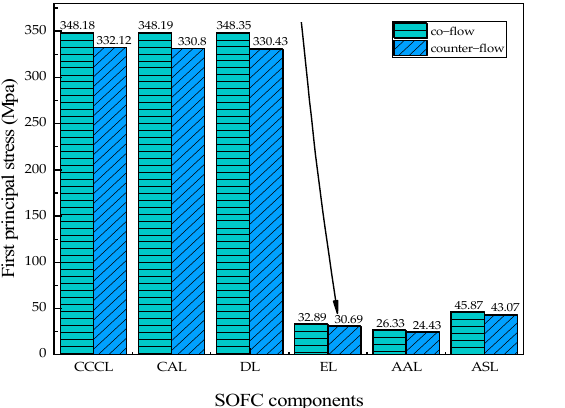
SOFC components Figure 14. Distribution of maximum value of first principal stress for each component for case C.